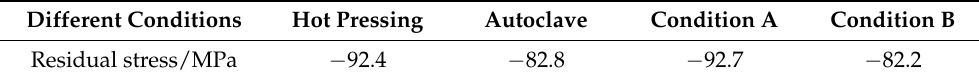
Figure 9. Influences of different process conditions on the evolution of residual stresses. Condition A: the external load was added on all the surfaces of the laminate; Condition B: the thermal boundary condition was replaced by convection heat transfer. Table 6. Final residual stresses in the GFRP layer under different